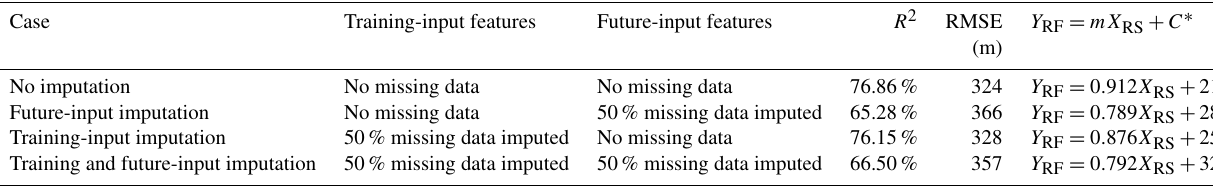
Table 2. Data imputation evaluation and performance on boundary layer heights for the year